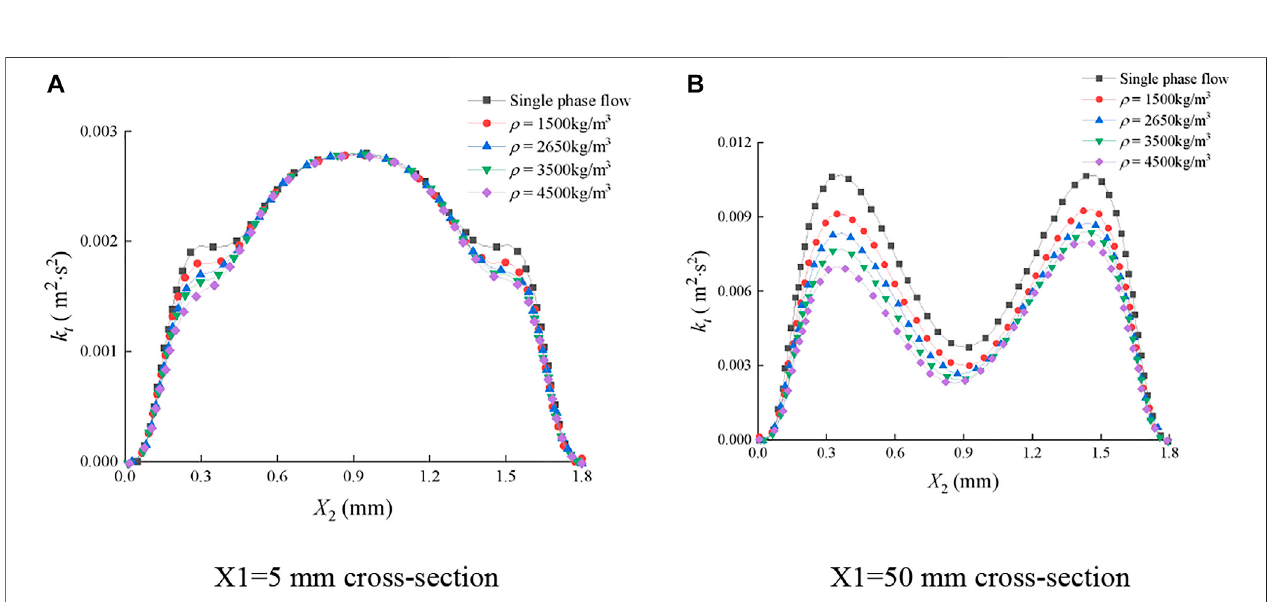
FIGURE 18 | Distribution of turbulent kinetic energy of the continuous-phase fl uid on cross sections of the smooth fracture. (A) X1=5 mm cross section, (B) X1=50 mm cross section.